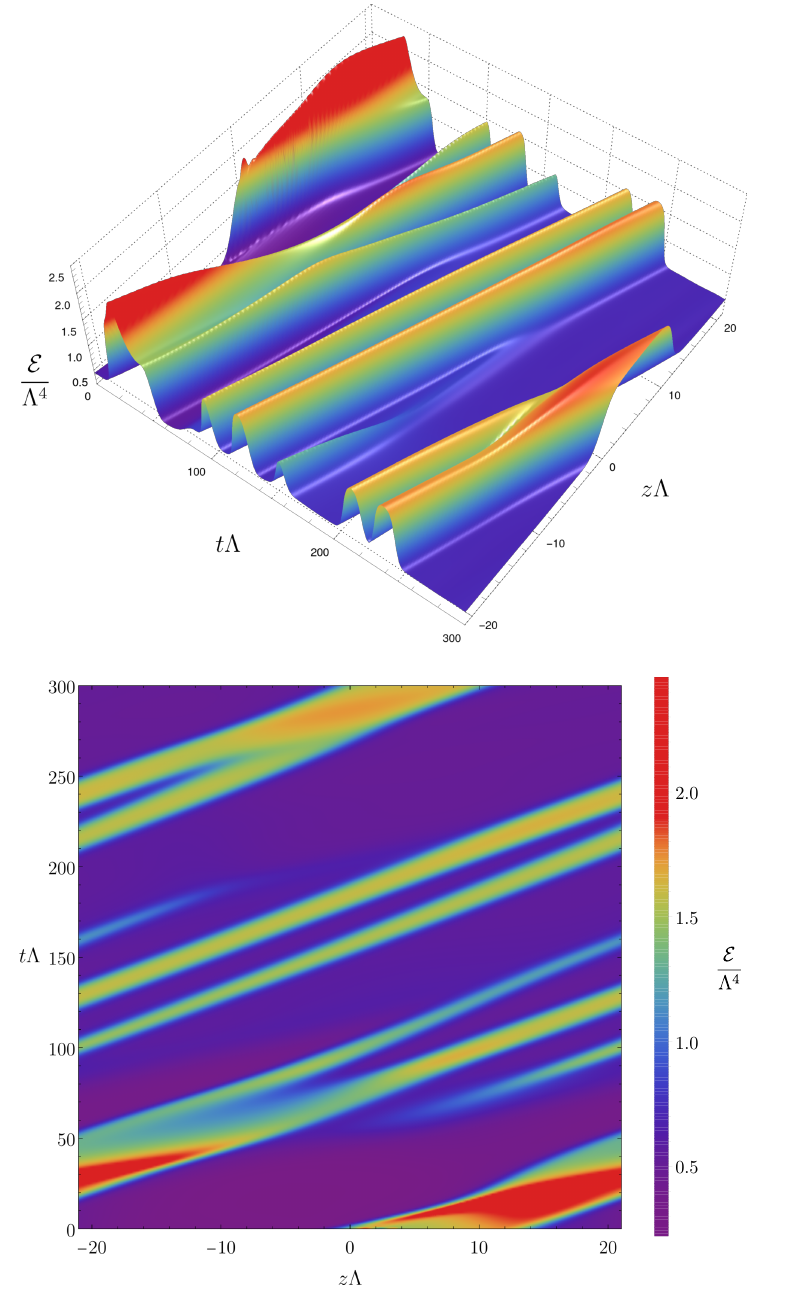
Figure 4 . Plots of the energy density for the evolution of an initial, single-domain state that splits into several fragments that subsequently merge back into a single